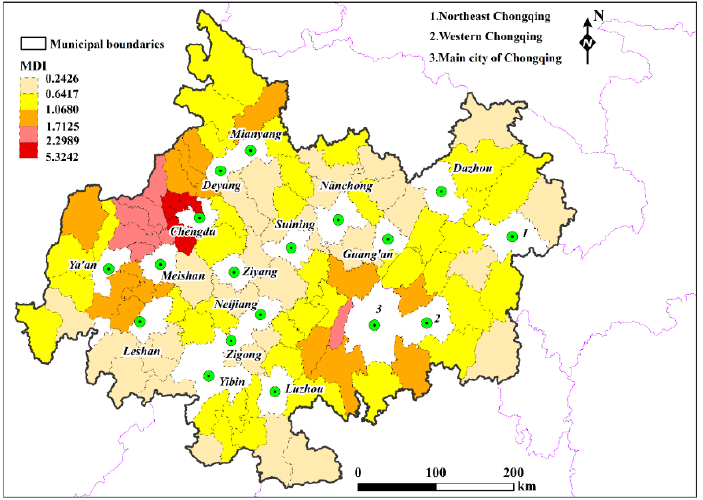
Figure 7. Spatial distribution of MDI in 2020. Notes: MDI was calculated according to Formula (6).